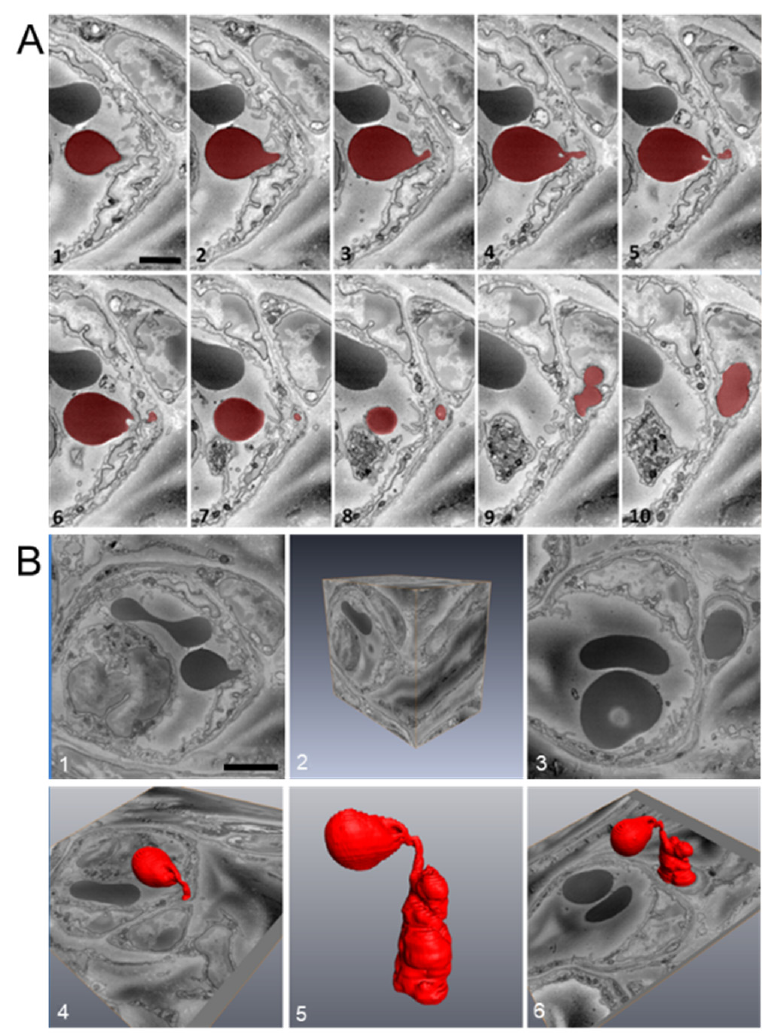
Figure 8. RBC extravasation after corneal abrasion. ( A ) Sequential images (1–10) were acquired using serial block-face scanning electron microscopy (SBF-SEM) and used to confirm RBC (colored red) passage across the venular endothelium. ( B ) Three-dimensional reconstruction analysis of the complete image stack (part of which is shown in panel ( A )) illustrates the high degree of RBC deformability (panel B5) needed to pass through the endothelium.